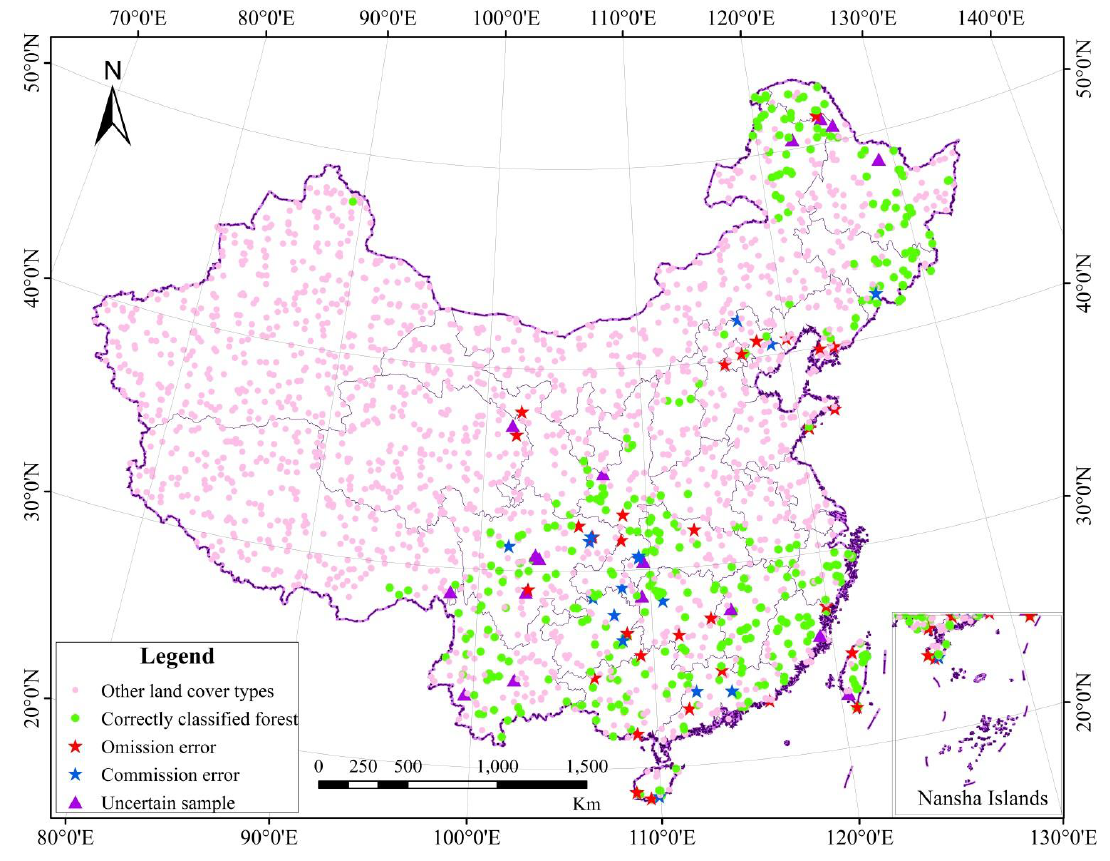
Figure 4. The distribution of the test samples and